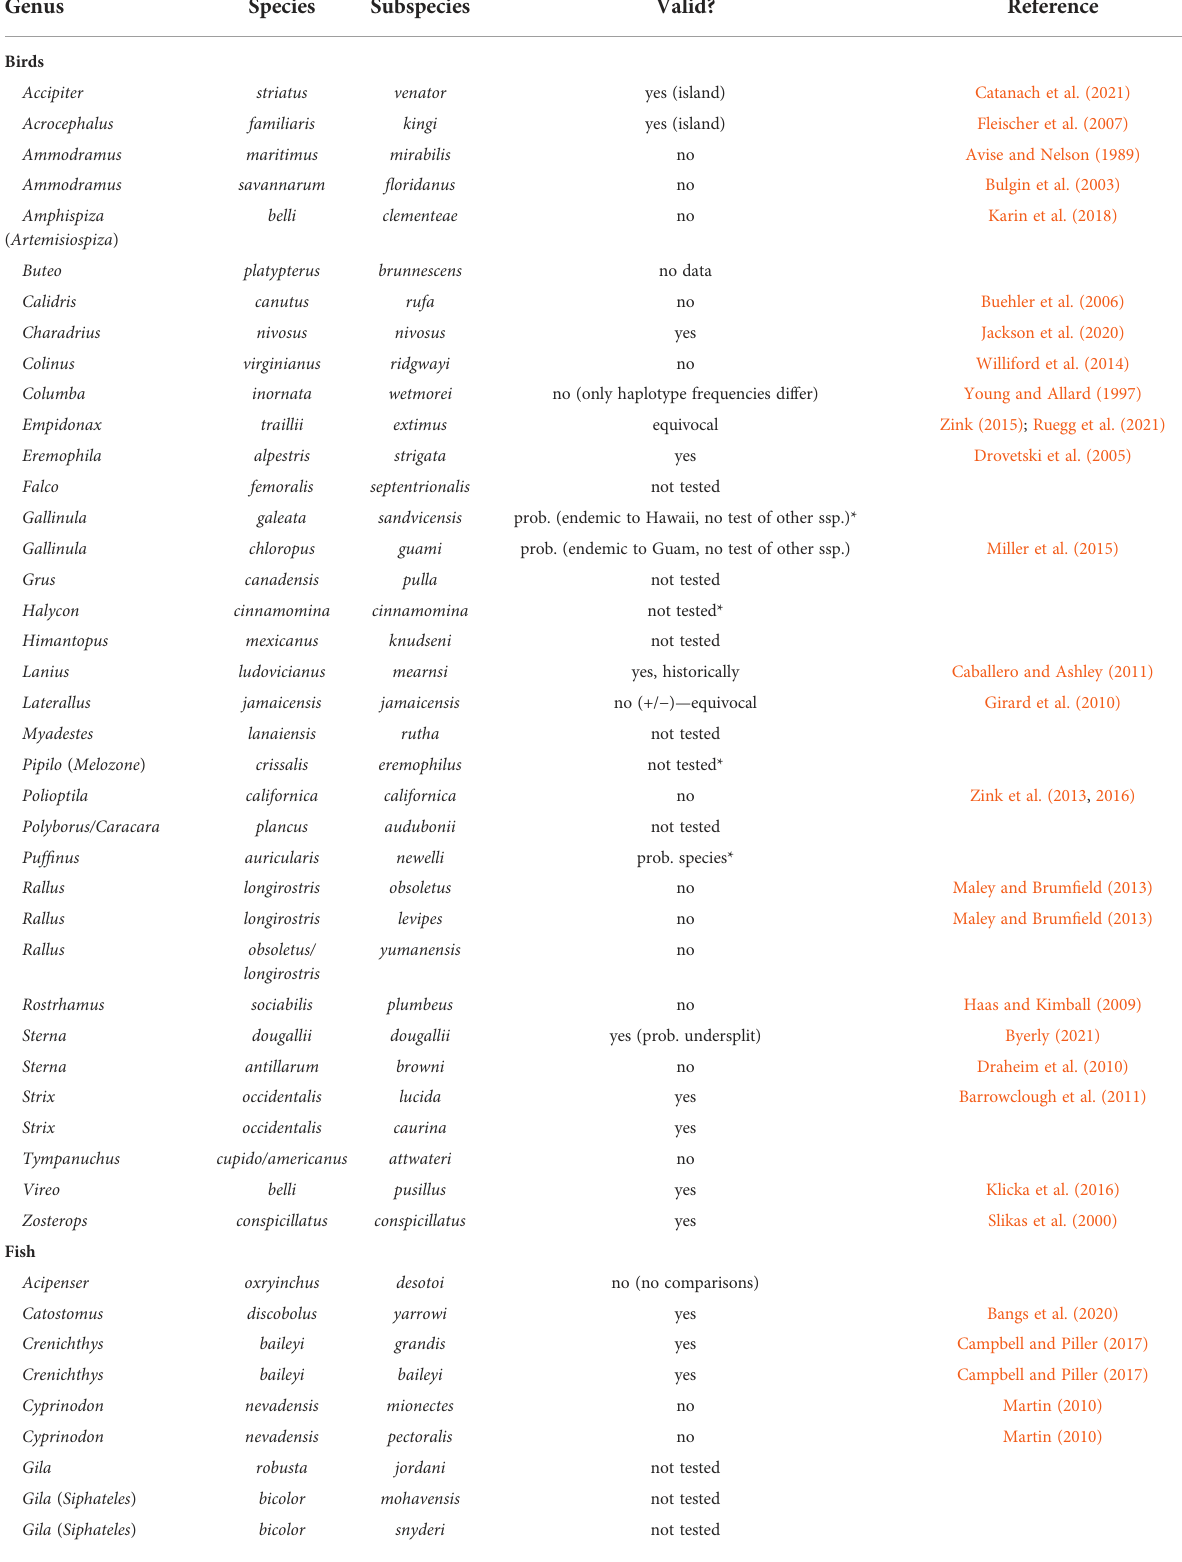
TABLE 1 Review of Subspecies Listed under the US Endangered Species Act.